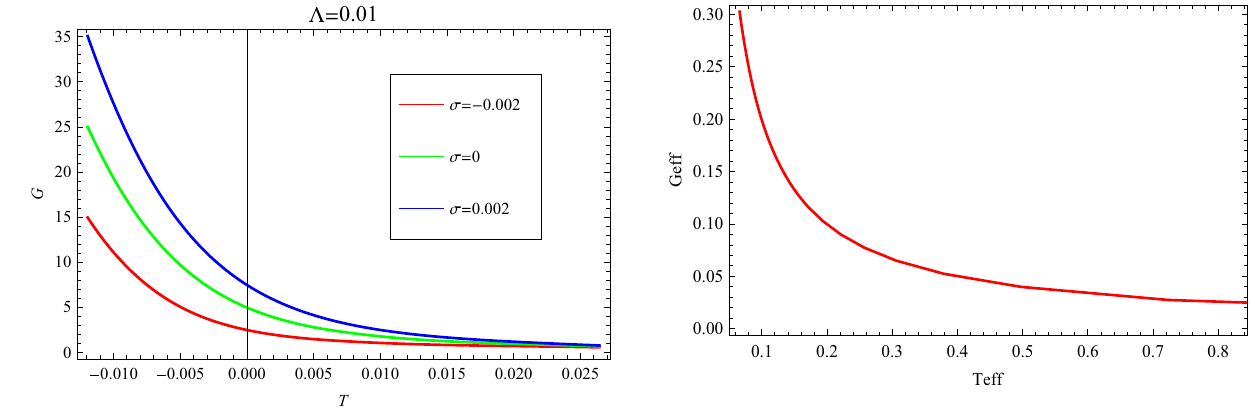
Fig. 2 Plot of Gibbs free energy versus temperature in the presence of surface tension for first case when cosmological constant is positive and Q m = 1 of the non-minimal MCRBH